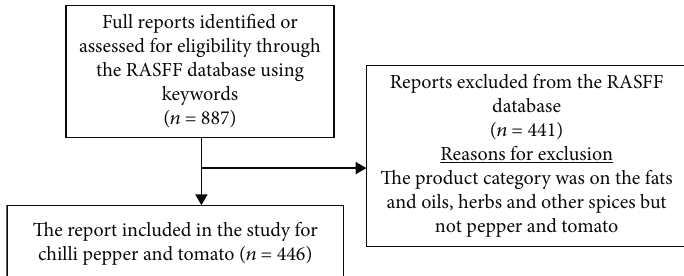
Figure 1: Schematic representation of data identi fi cation and exclusion